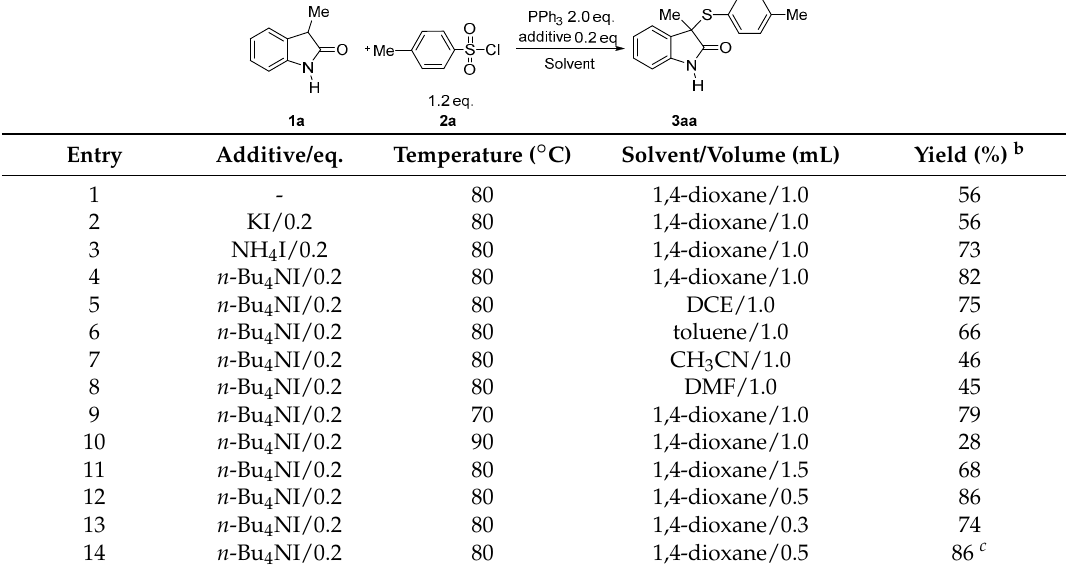
Molecules 2017 , 22 , 1208 3 of 11 were as follows: 1a (0.5 mmol), 2a (0.6 mmol), PPh 3 (1.0 mmol), n -Bu 4 NI (0.1 mmol), and 1,4-dioxane (0.5 mL) at 80 ° C. Table 1. Optimisation of 3-methylindolin-2-one ( 1a ) thiolation by 4-methylbenzenesulfonyl chloride ( 2a ) in the presence of PPh 3 . a